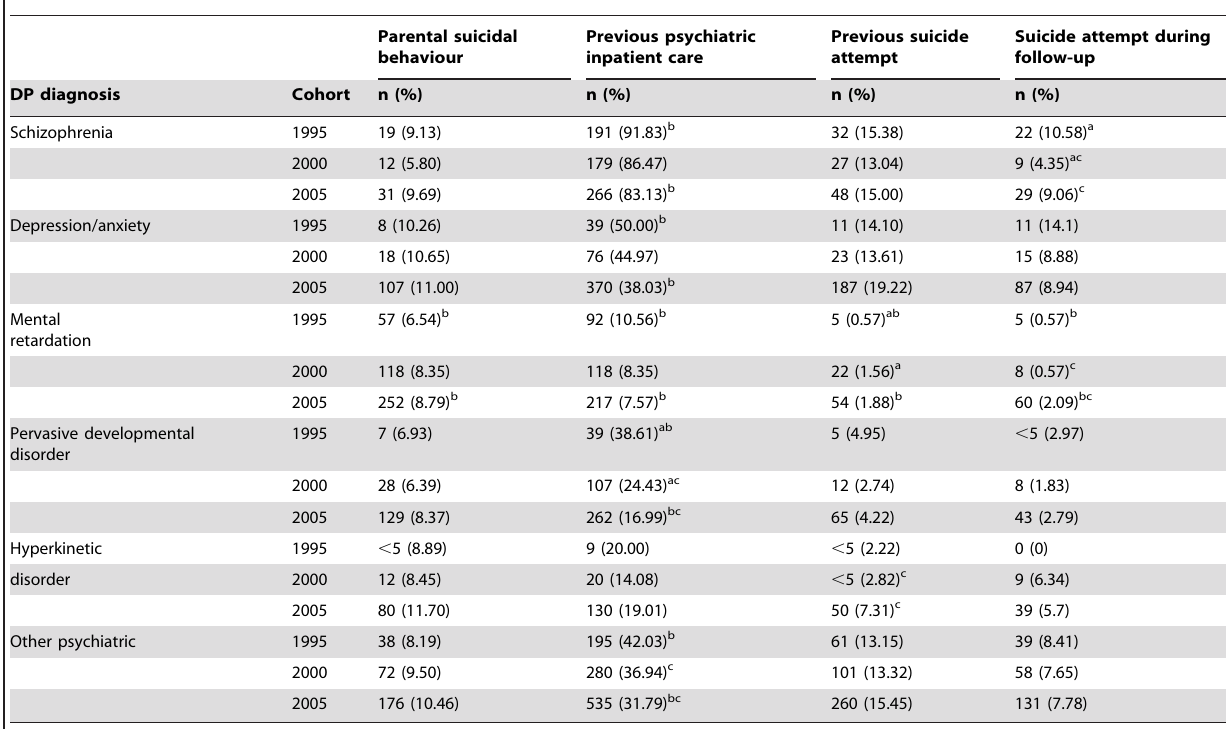
Table 4. Parental suicidal behaviour, own inpatient care due to psychiatric diagnoses, suicide attempt six years prior to baseline, and inpatient care due to suicide attempt during a five-year follow-up in young adults (19–23 year) with disability pension (DP) due to specific psychiatric diagnoses in 1995, 2000 and 2005, respectively.